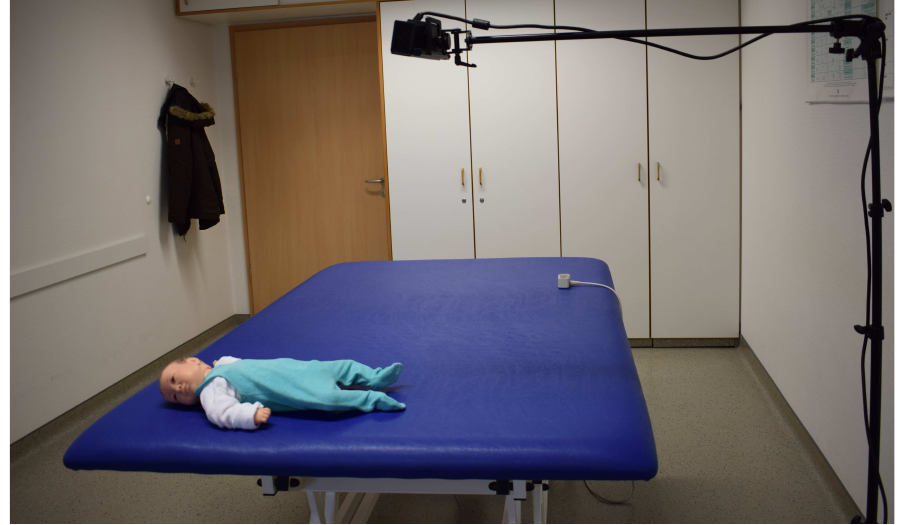
Figure 7. Camera setup in dataset